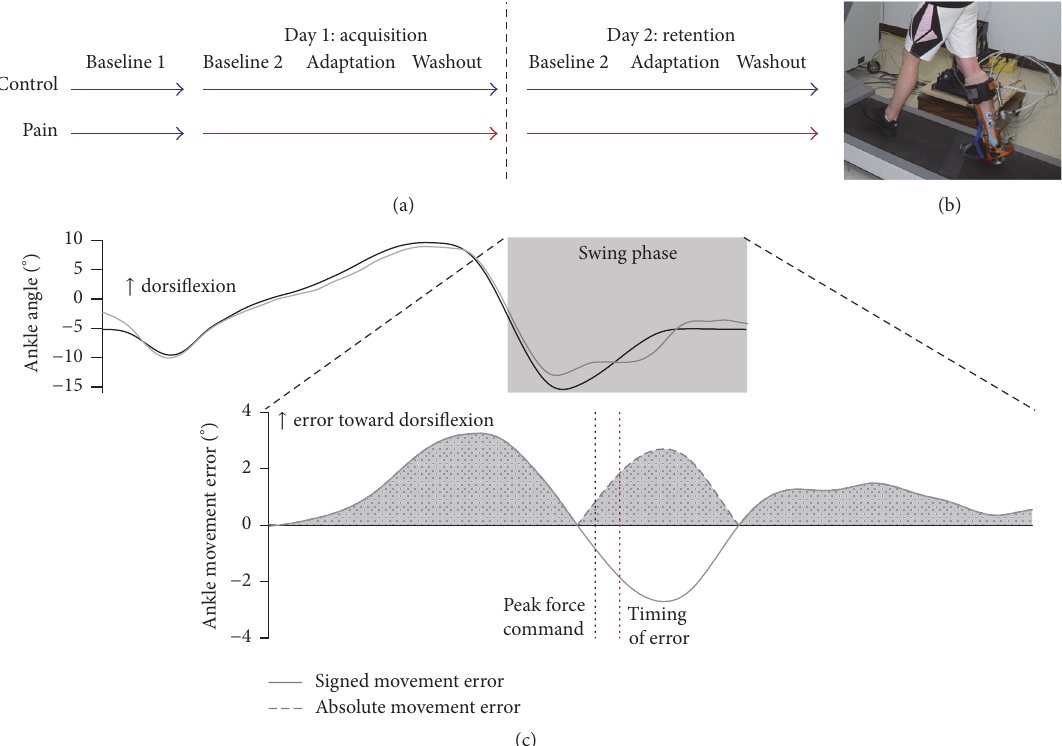
Figure 1: (a) General protocol of the experiment: blue and red arrows illustrate phases of the experiment performed without and with pain, respectively. (b) Robotized ankle-foot orthosis (rAFO). (c) Ankle kinematics outcome measures: the upper panel presents ankle angle during baseline gait (black) and adaptation (gray) for the whole stride duration. The lower panel illustrates the signed and absolute ankle movement error during the swing phase. The gray shaded area illustrates the mean absolute error outcome measure. The black and red dotted lines show the peak force command and the timing of movement error,